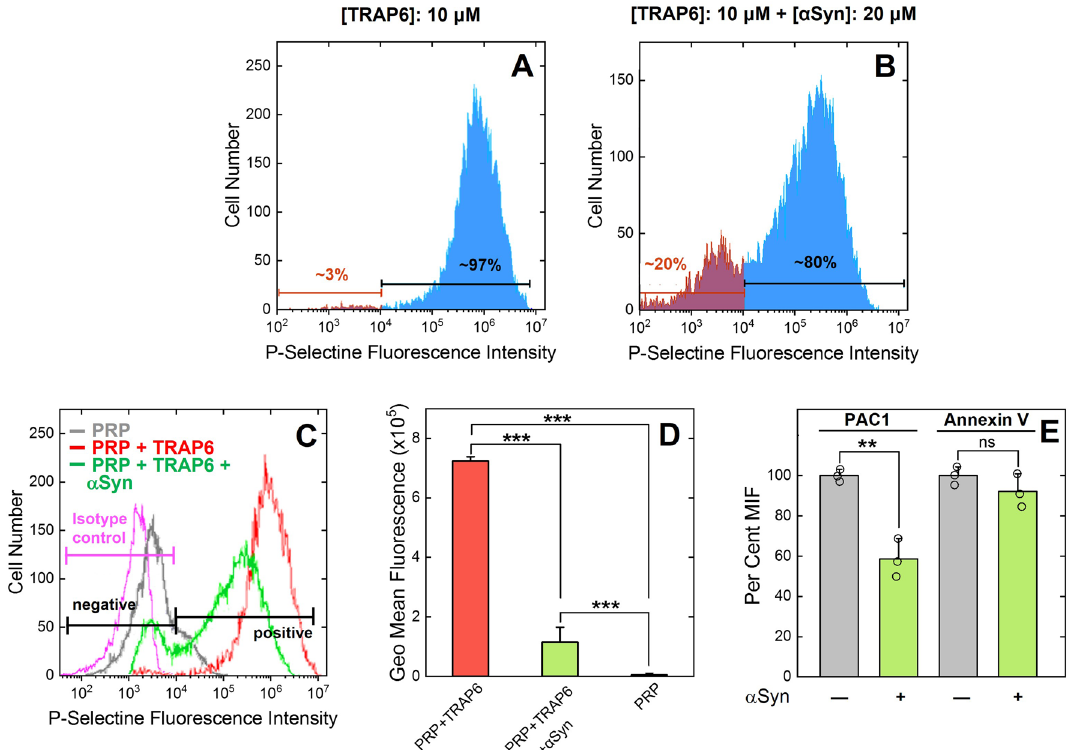
Figure 3. Flow Cytometry analysis of the effect of α-Syn on platelet activation after PAR1 stimulation with TRAP6. ( A , B ) Representative plots of P-selectin expression. P-selectin expression was detected using a phycoerythrin (PE)-conjugated monoclonal anti-human P-selectin (CD62P) antibody. A PRP sample (10 μl, 1 × 10 6 platelets) was incubated with TRAP6 (10 μM) for 30 min at 37 °C, in the absence ( A ) and presence ( B ) of αSyn (20 μM). Fluorescence intensity was measured by flow cytometry after incubation of PRP with anti- CD62P-PE monoclonal antibody (20 min at r.t. in the dark). Values are reported as the mean relative abundance, resulting from three different determination, with errors (±) as S.D. ( C ) Overlay of the fluorescence intensity plots in panels A and B. The trace of PRP in the presence of anti-CD62P-PE antibody is shown in grey, while the negative isotype control with anti-mouse IgG1 PE-conjugated antibody is in magenta. The fluorescence intensity threshold, used to discriminate between activated (i.e. P-selectin positive) and non-activated (i.e. P-selectin negative) platelet subpopulations, was set at 10 4 as indicated, and the % subpopulation was calculated by integration of the area under the curve (see “Methods”). ( D ) Quantitative GeoMean analysis of P-selectin (anti-CD62P-PE moAb) fluorescence intensities reported in panel ( C ). Data derive from three independent measurements (n = 3), with error bars ± SD. ( E ) Histogram plot of the mean fluorescence intensity (MFI) of FITC-labelled PAC-1 moAb, for the quantification of activated GP IIb /GP IIIa , and DY634-labelled Annexin-V, for the quantification of PS exposure. Data are extracted from the images in the Supplementary Fig. S3 and are reported as per cent values, relative to the MFI of TRAP6-stimulated PRP alone without αSyn, which was set at 100%. Data points are shown as empty circles ( ○ ), while the height of the histograms is the mean value ± SD (n = 3). Significant differences were obtained from One-way ANOVA test and are indicated by lines joining the data being compared (*** p < 0.001; ** p < 0.01; * p < 0.05; ns: not